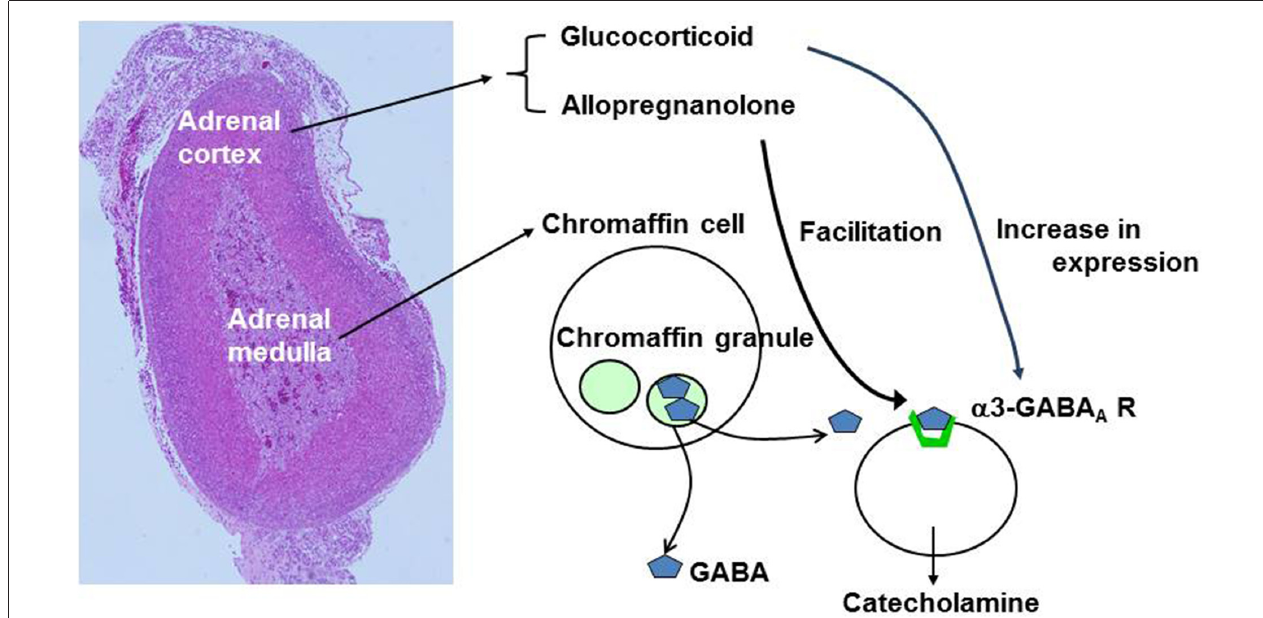
FIGURE 6 | Summary of effects of adrenal cortical hormones on GABA signaling . The left image represents hematoxylin-eosin staining of mouse adrenal gland. GABA is stored in large dense core vesicles (LDCVs) or chromaffin granules in chromaffn cells. Glucocorticoids produce an increase in expression of − channel α 3-containing GABA A receptors whereas allopregnanolone produces facilitation of GABA A receptor Cl